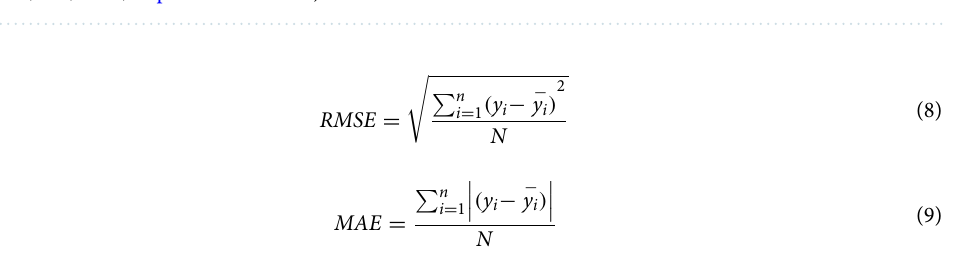
Figure 3. Spatial clusters using Moran’s I index. This map was generated using the tool of ArcGIS 10.3 (ESRI, Redlands, CA, USA,